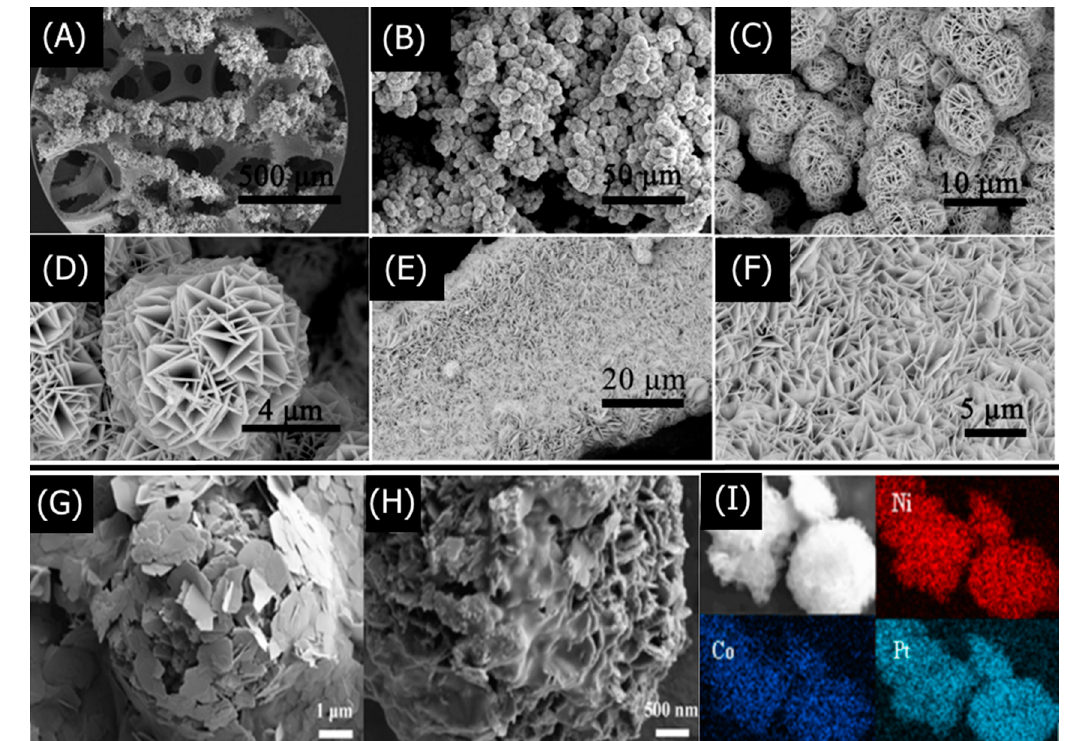
Figure 7. SEM micrographs of the outer surfaces of the NiFe-LDH/Ni foam at ( A , B ) low and ( C , D ) high magnifications, and the inner surfaces at ( E ) low and ( F ) high magnifications, reproduced from reference [134] with permission from Elsevier B.V., 2018. SEM micrographs of ( G ) bare NiCo-LDH and ( H ) Pt-doped NiCo-LDH; ( I ) elemental mapping of Ni, Co, and Pt in the Pt-doped LDH nanocomposite, reproduced from reference [52] with permission from Elsevier,